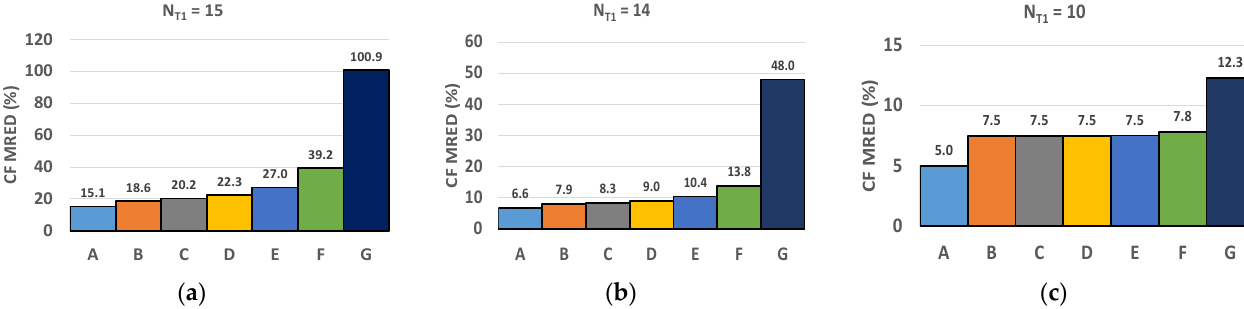
Figure 9. MRED of CF dyn and CF static for a 7 × 7 convolution applied on the airplane benchmark: ( a ) N T 1 = 15, ( b ) N T 1 = 14, ( c ) N T 1 = 10. F = 8.